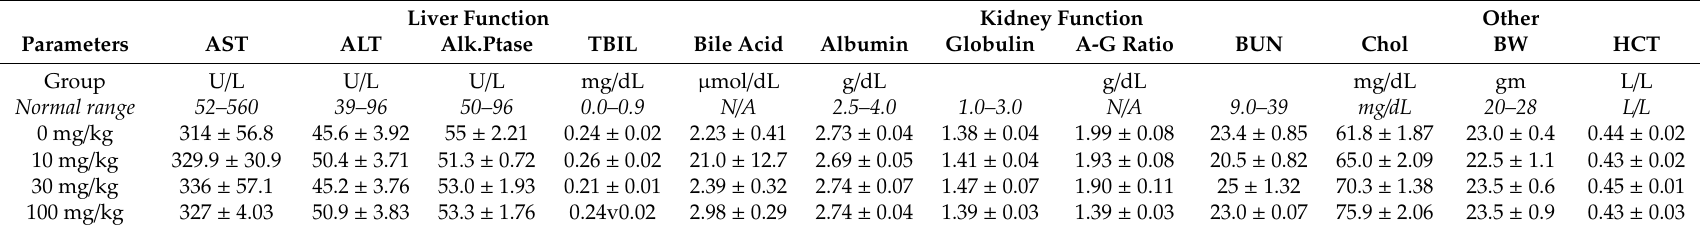
Table 3. Plasma biochemistry. Chronic toxicity (athymic nude mice): plasma